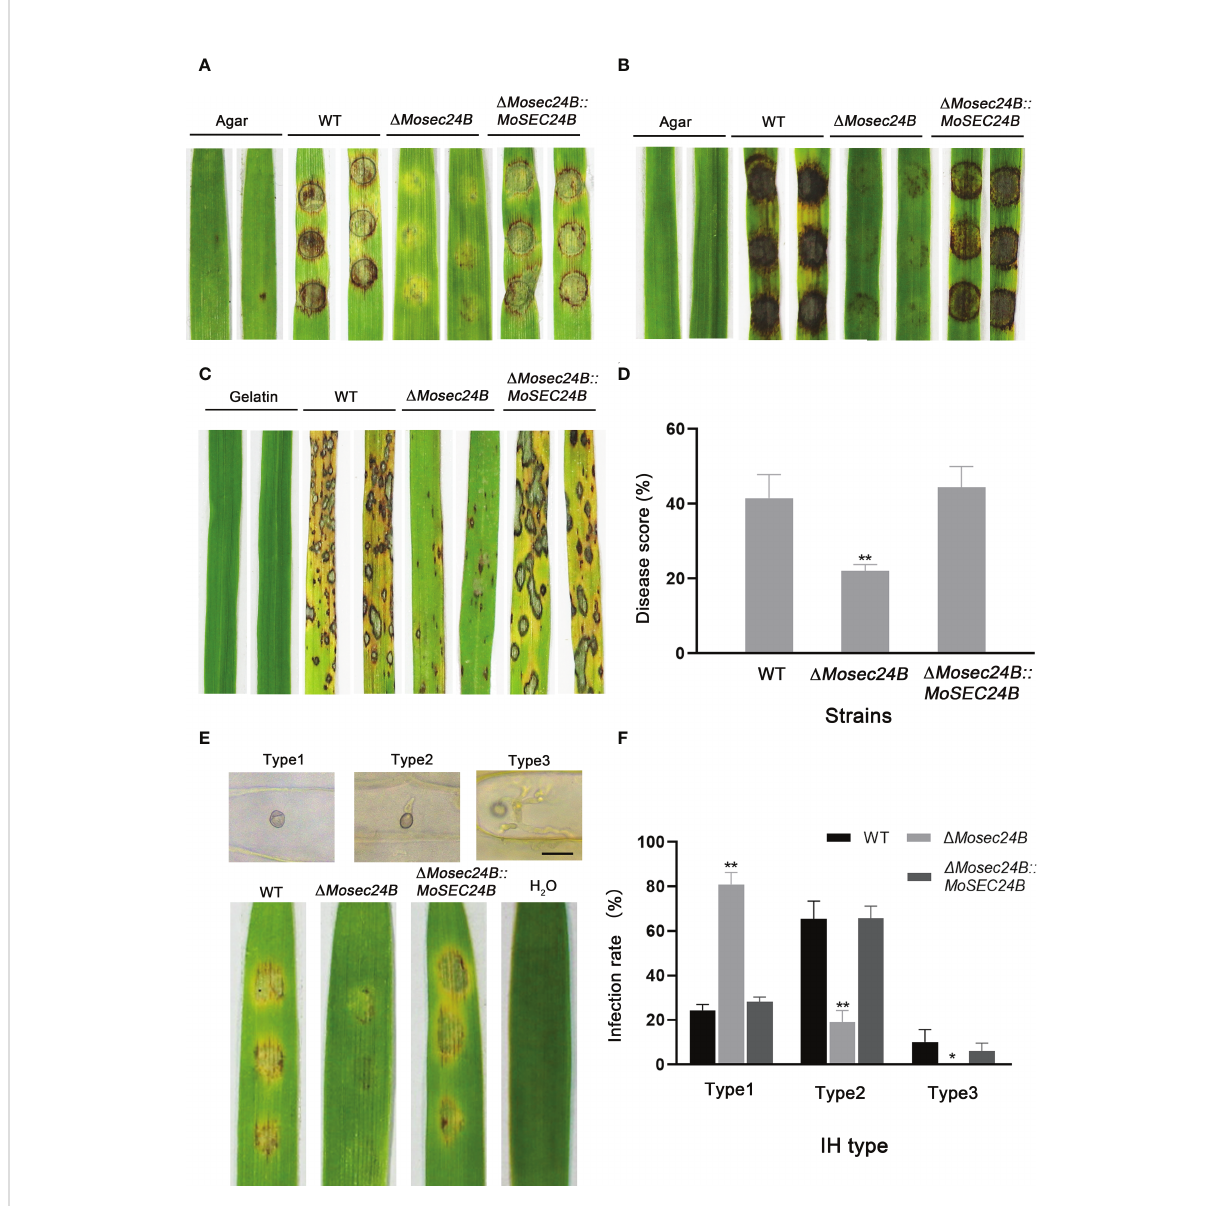
FIGURE 4 MoSec24B is important for pathogenicity. (A) Mycelial plugs from WT, D Mosec24B , and D Mosec24B::MoSEC24B strains were inoculated on detached barley leaves. (B) Mycelial plugs from WT, D Mosec24B , and D Mosec24B::MoSEC24B strains were inoculated on detached rice leaves. (C) Conidial suspensions (5 × 10 4 conidia/ml) from WT, D Mosec24B , and D Mosec24B::MoSEC24B strains were sprayed on rice seedlings. (D) Disease areas of rice leaves whose length is 5 cm were measured using Photoshop CS6. (E) Conidial suspensions (5 × 10 4 conidia/ml) from WT, D Mosec24B , and D Mosec24B::MoSEC24B strains were sprayed on barley leaves for 4 days, and IHs on barley cells were divided into three types. Scale Bar = 20 m m. (F) Statistical analysis of three IH types from WT, D Mosec24B , and D Mosec24B::MoSEC24B strains. Error bars represent the standard deviation. An analysis of the data was carried out using an unpaired two-tailed Student ’ s t-test. Asterisks represent statistically signi fi cant differences in the data (**P < 0.01, *P <